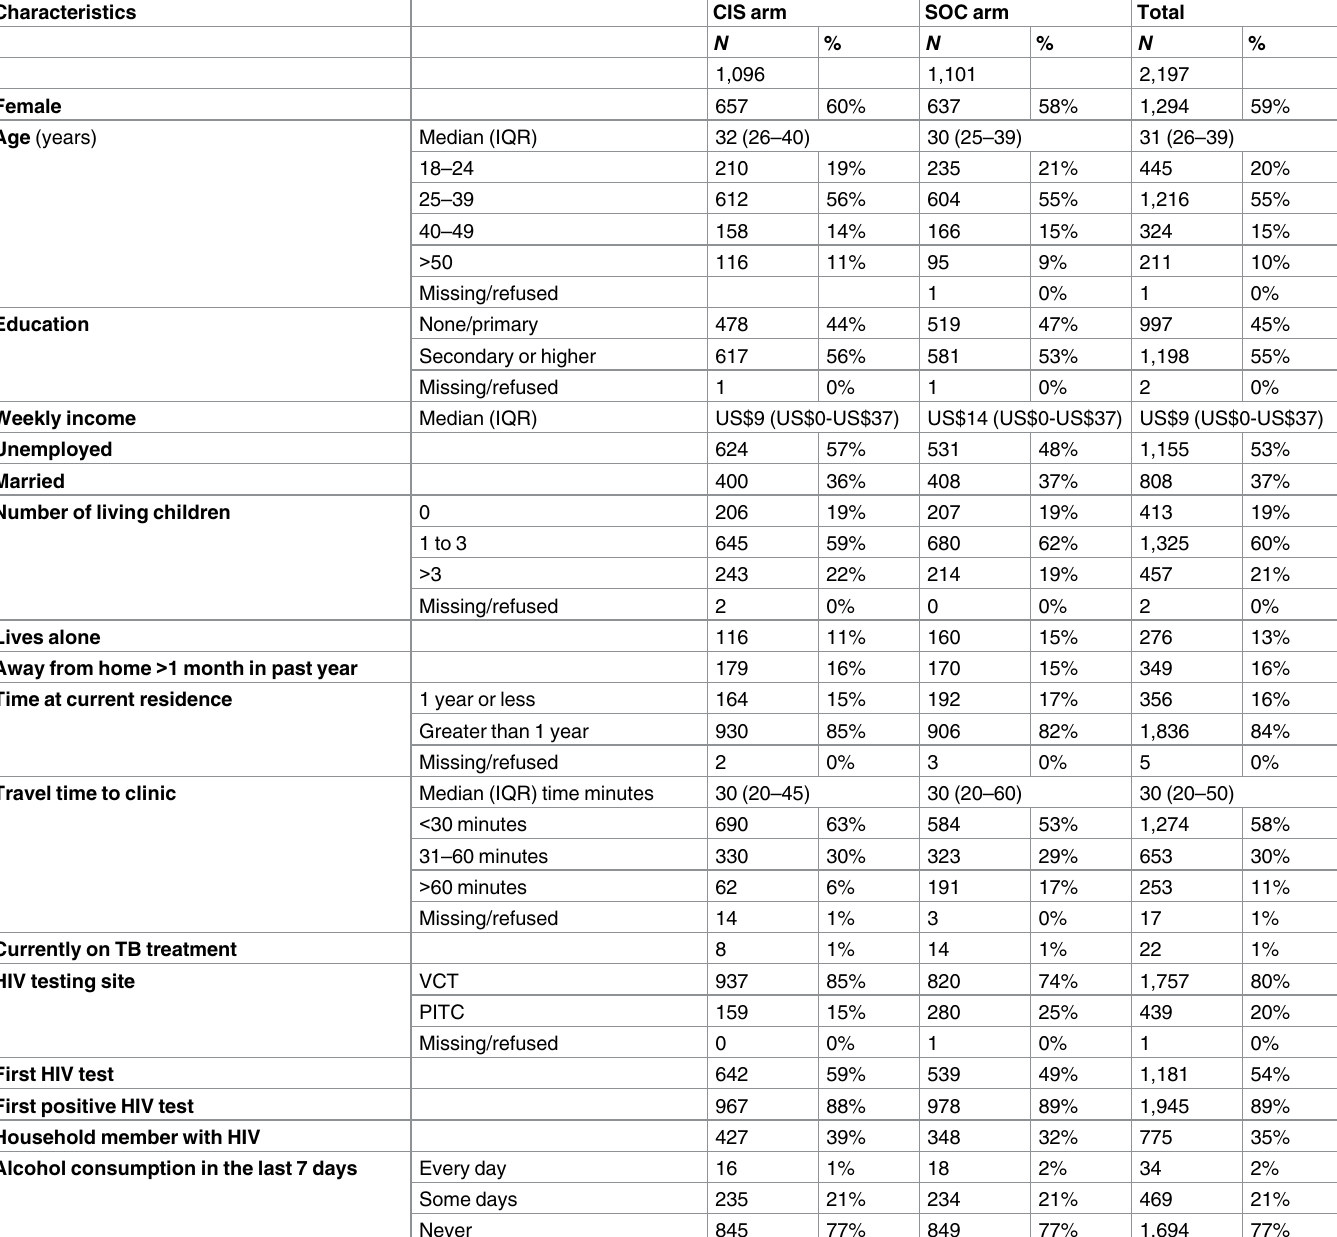
Table 2. Participant characteristics at HIV testing ( N =